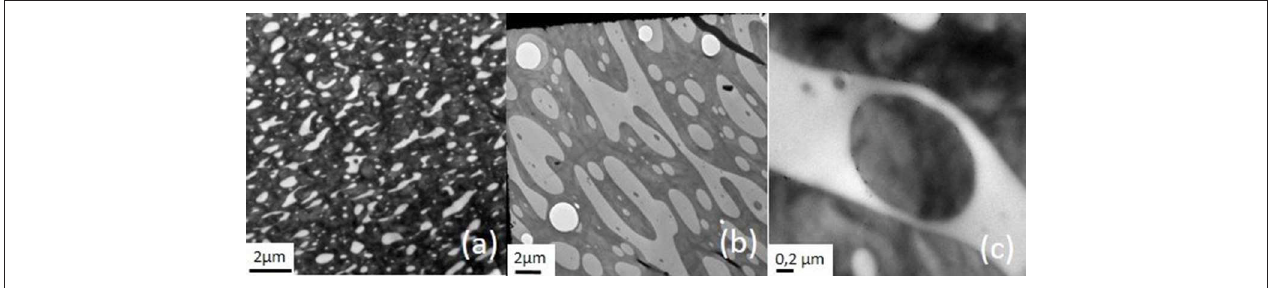
FIGURE 2 | TEM images of (a) poly(butylene succinate) (PBS)/poly(lactic acid) (PLA) (60:40) wt phr, (b,c) PBS/PLA/deep eutectic solvent (DES) (60:40:1) wt phr.